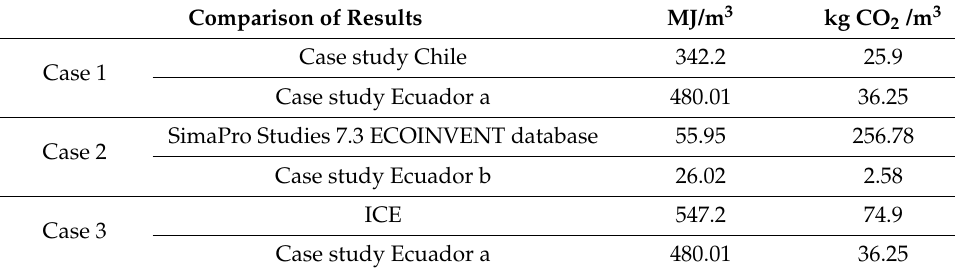
Table 3. Comparison of three concrete case studies in the “gate to gate” boundary